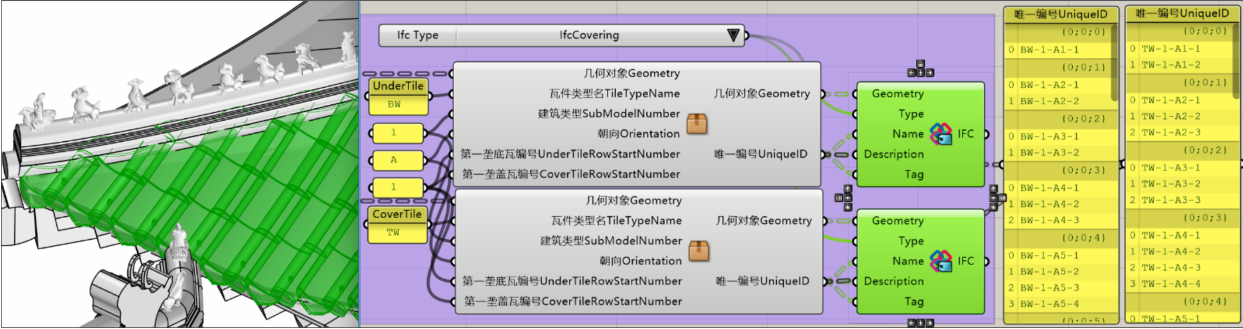
Figure 8. Identifiers given to tiles before baking to